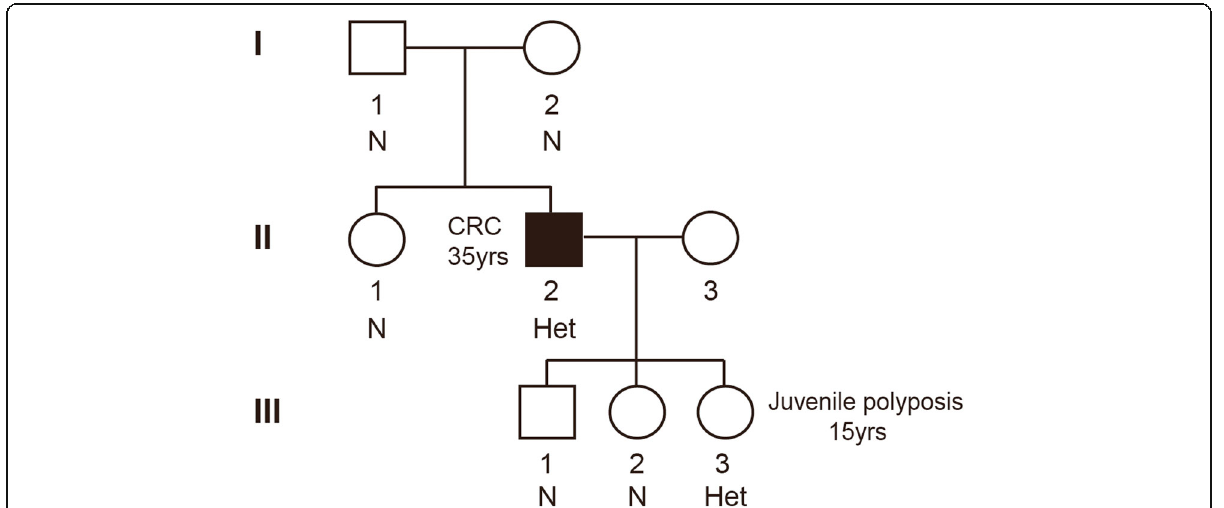
Fig. 1 The pedigree of the family investigated in this study, with the proband indicated by the black shading. Age of onset is noted beside the family member. The status of BMPR1A variant is listed beneath each family member. CRC, colorectal cancer. N, none. Het,